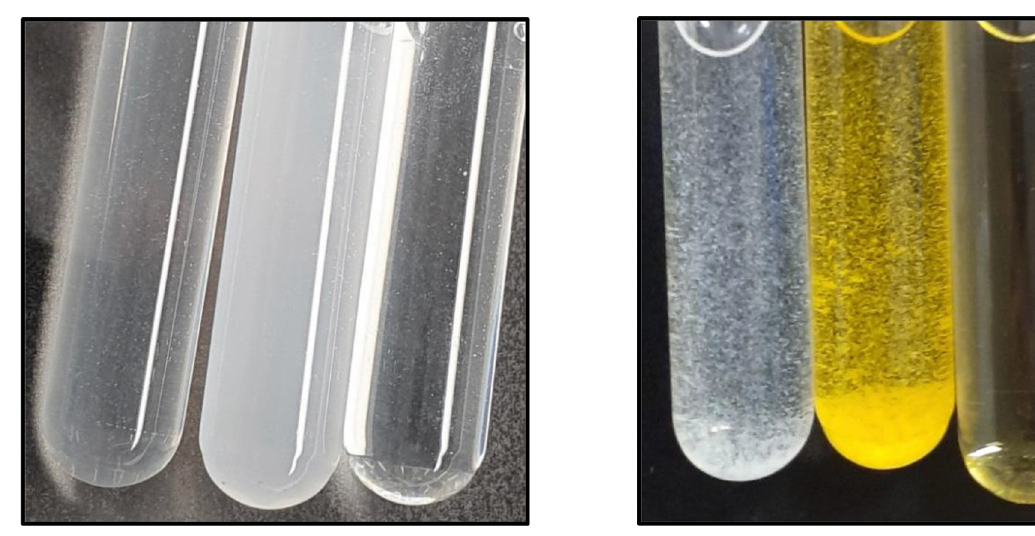
Figure2: Mixtureof pantoprazolesodium(PS)